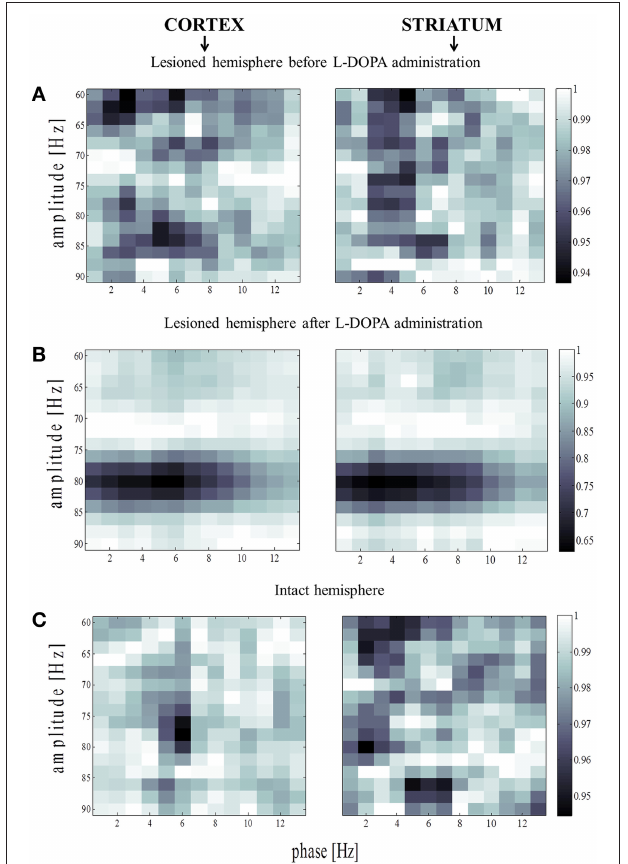
FIGURE 7 | Amplitude modulation of fast rhythms by the theta phase. (A) Average phase-amplitude coupling values for the lesioned hemisphere before levodopa administration. Values were normalized separately for each column by dividing all values with the maximum value across it. (B) The same analysis as in (B) for the lesioned hemisphere after levodopa administration. (C) Phase-amplitude coupling values for the intact hemisphere before levodopa administration [the same analysis as in (A) ].